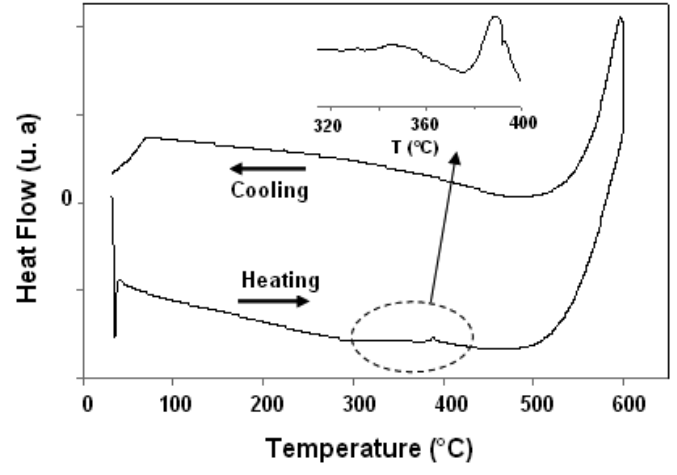
Figure 3. DSC scans for as-spun ribbons upon heating and cooling at a rate of 10